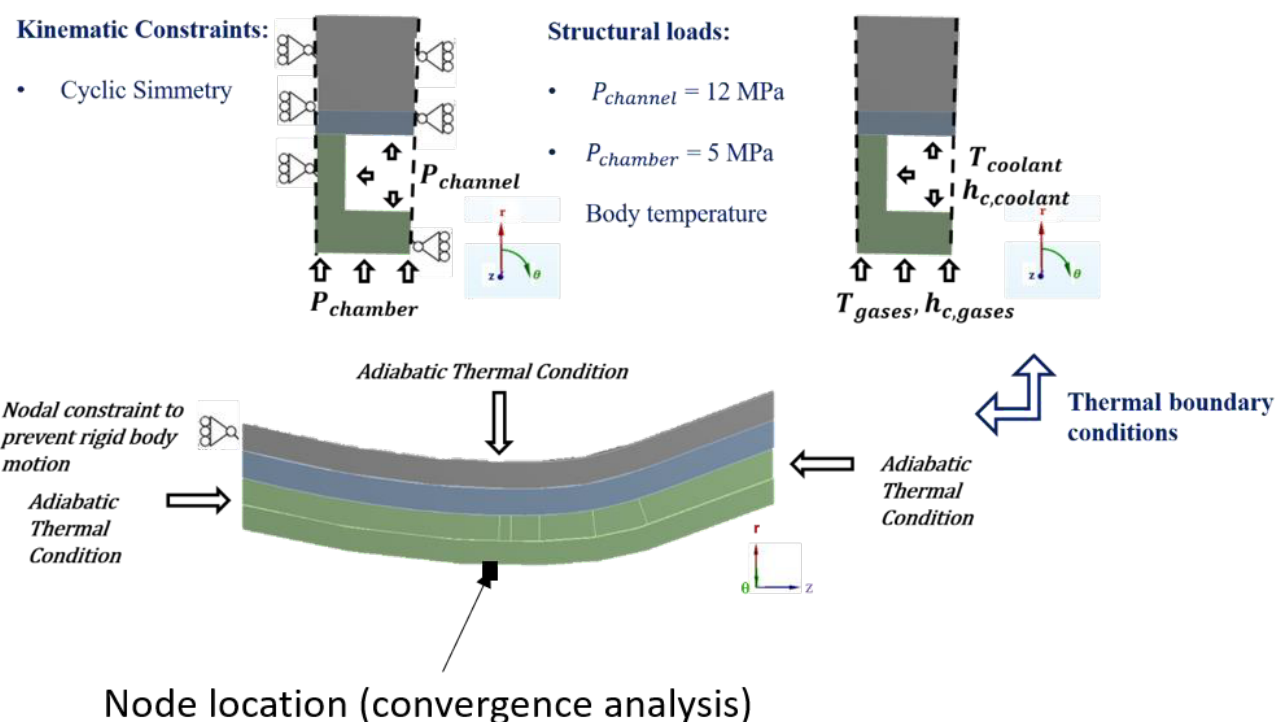
Figure 7. Thermal and structural boundary conditions.